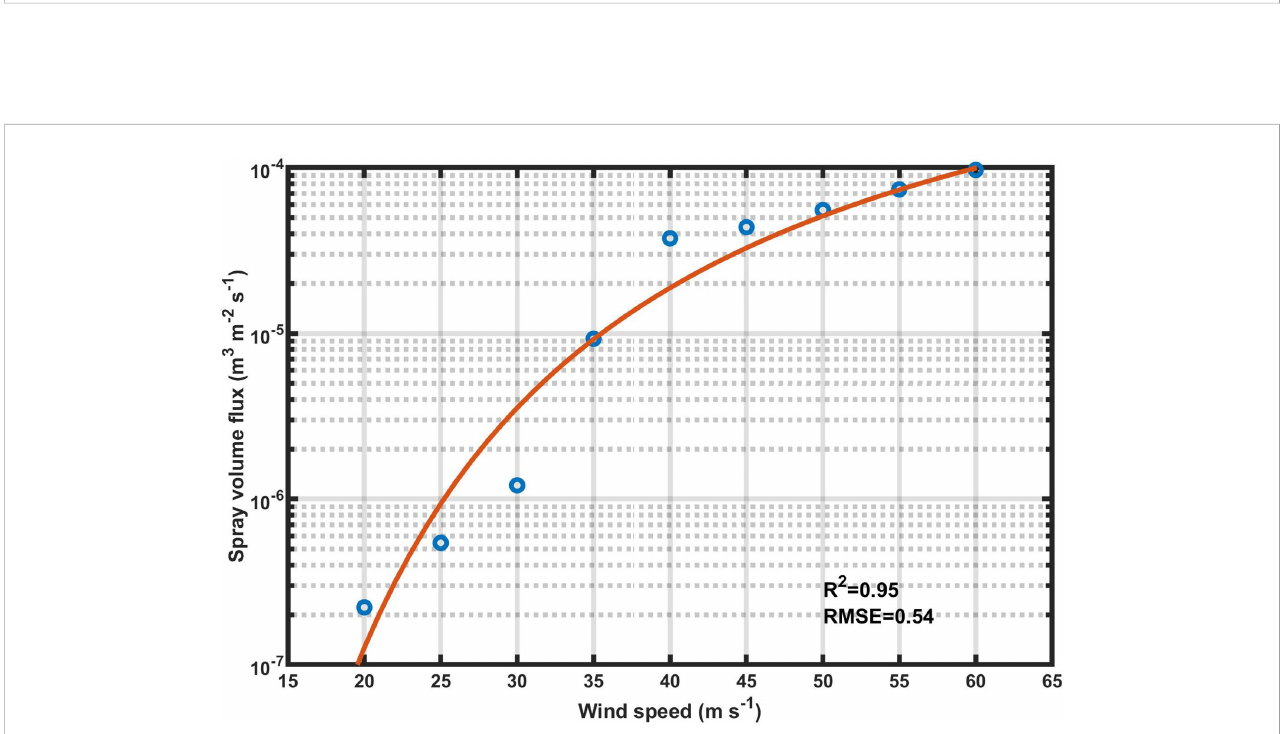
FIGURE 7 Spray volume fl ux as a function of wind speed for the laboratory observations (blue circles), and the regression (Equation 14) of spray volume fl ux onto wind speed (red